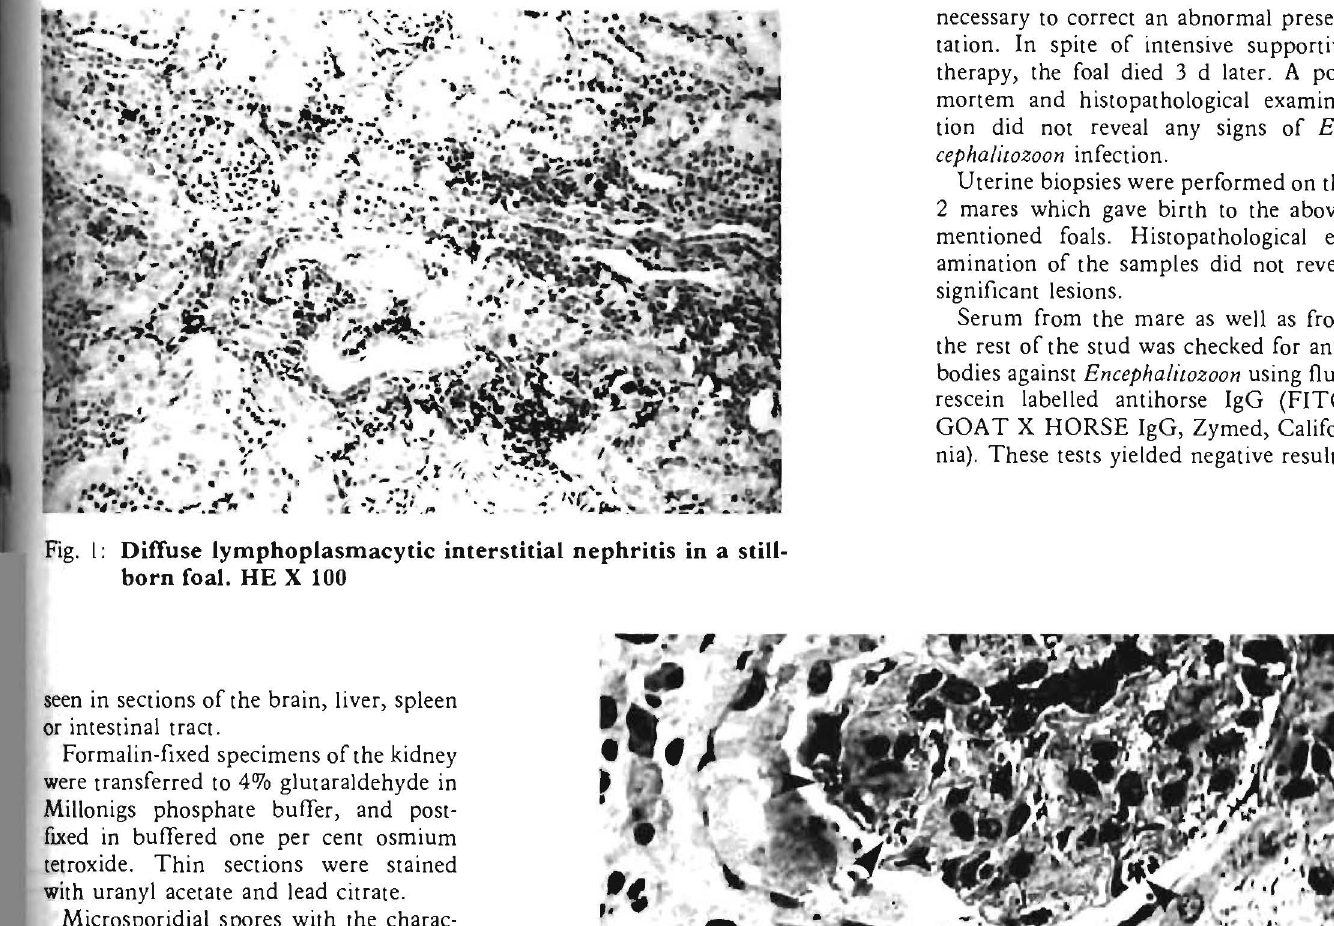
Fig. 2: Encephalitozoon cuniculi parasites in the glomerular en dothelium and some free-lying organisms in Bowman's space (arrow)', Toluidine Blue X 1000